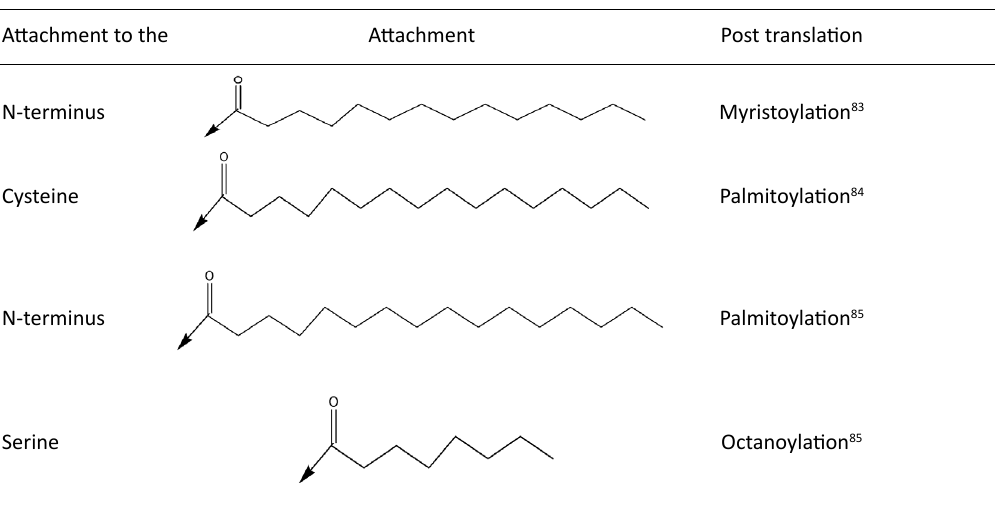
Serine Octanoylation